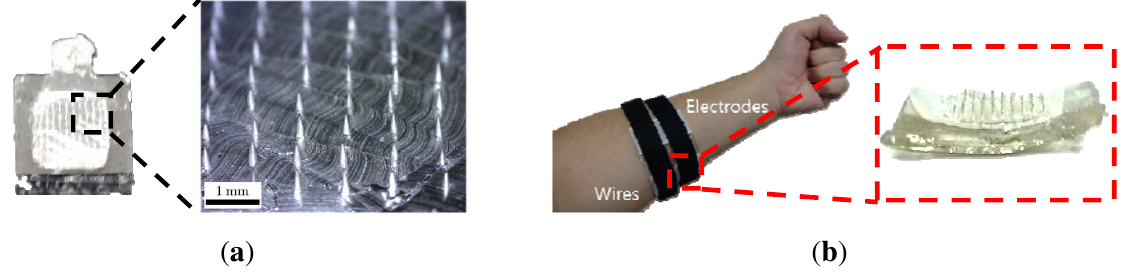
Figure 9. Images of the proposed MNA electrode and band system. ( a ) Microscopic image of the planar MNA electrode; ( b ) image of skin-attached PDMS